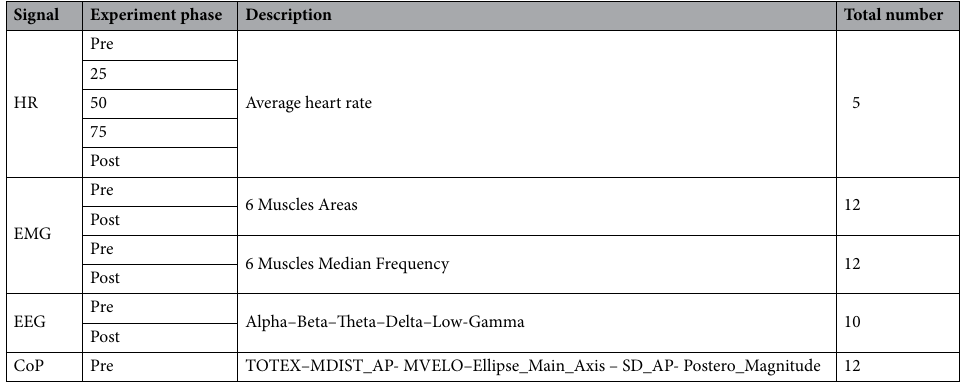
Table 7. The 51 selected features from the BioVRSea